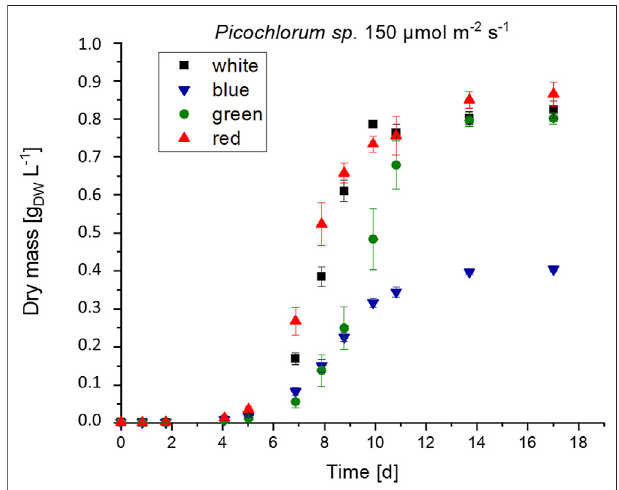
FIGURE 3 | Biomass formation of Picochlorum sp. at 150 μ mol m − 2 s − 1 irradiance with white, blue, green and red light illumination (n =